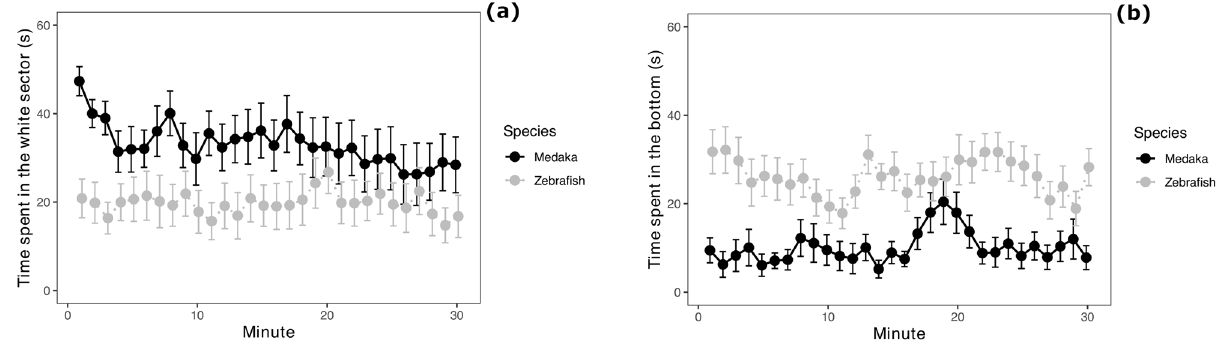
Figure 3. Scototaxis test and the diving test. ( a ) Time spent by subjects in the white sector of the scototaxis apparatus, divided in 1-min bins; ( b ) time spent by subjects in the bottom sector (25% of the area) of the diving test apparatus, divided in 1-min bins. Data points and error bars represents means and standard errors, respectively.